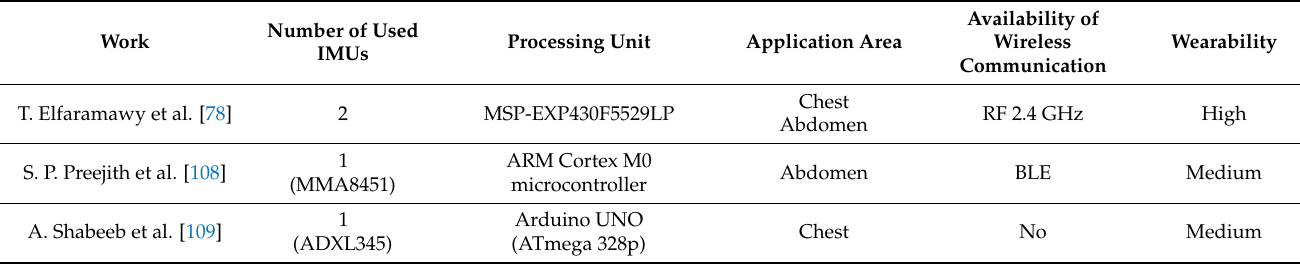
Table 4. Table with summarized the scientific works above discussed from the point of view of the number of used IMUs, processing unit, application area, availability of wireless communication and wearability.